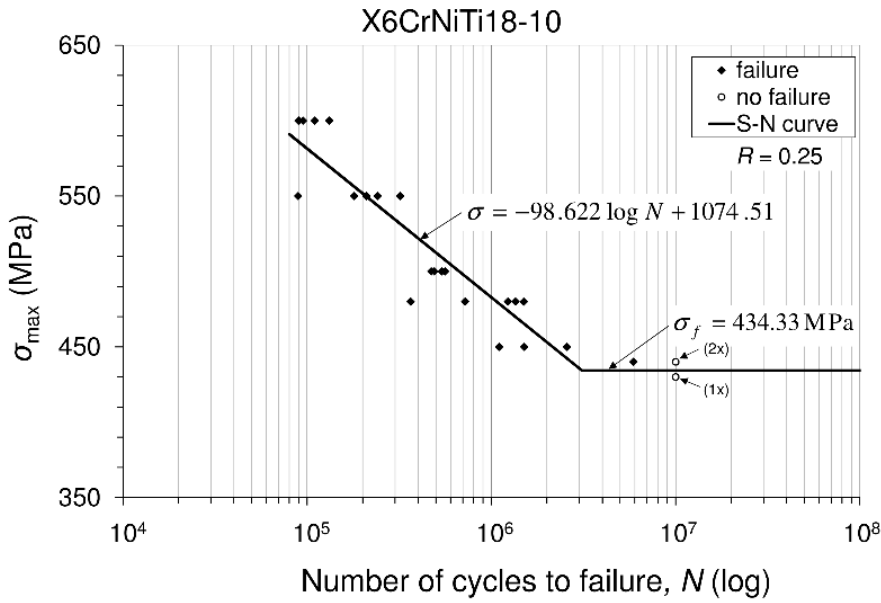
Figure 12. Fatigue tests (at room temperature and stress ratio R = 0.25) for X6CrNiTi18-10 steel: maximum stress versus number of cycles to failure ( ○ = no failure, ♦ = failure), approximated “ S-N ” curve (line) in fatigue limit region (\) and fatigue limit (endurance limit) in fatigue infinite region (–).